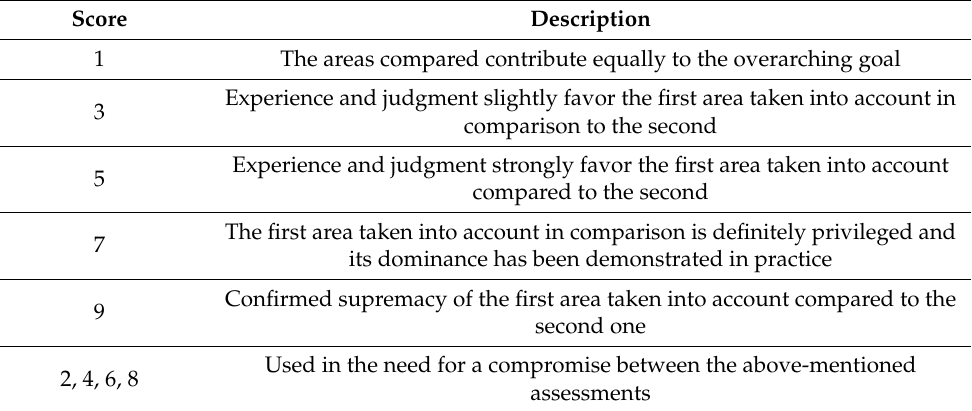
Table 3. The scale of the scoring of the preferences of one research area in direct comparison with another. Source: Own elaboration based on Satty [48]. Score Description 1 The areas compared contribute equally to the overarching goal Experience and judgment slightly favor the first area taken into account in 3 comparison to the second Experience and judgment strongly favor the first area taken into account 5 compared to the second The first area taken into account in comparison is definitely privileged and 7 its dominance has been demonstrated in practice Confirmed supremacy of the first area taken into account compared to the 9 second one 2, 4, 6, 8